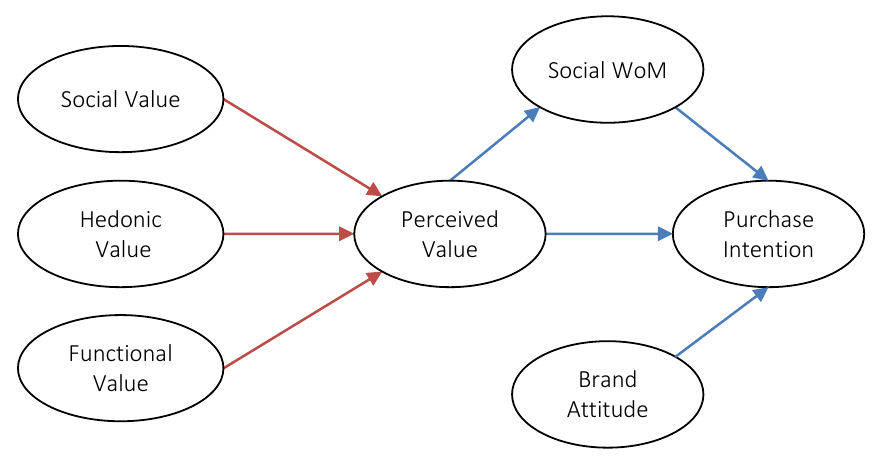
Figure 1. Conceptual